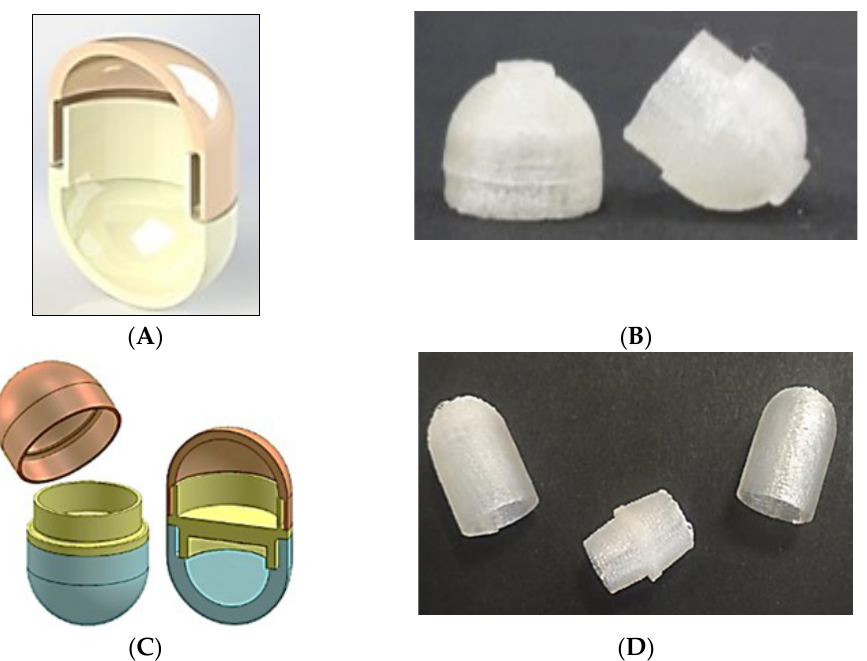
Figure 29. CAD designs of a cross-sectioned capsule ( A ) and multicompartment capsular system ( B ), and photographs of 3D printed body and cap ( C ) and bodies and spacer ( D ) fabricated by FDM 3D printing from Klucel ® LF. Adapted with permission from Ref. [70]. 2017, Elsevier. All the HPMC coated units (tablets, pellets, gelatin capsules) and HPC capsular devices